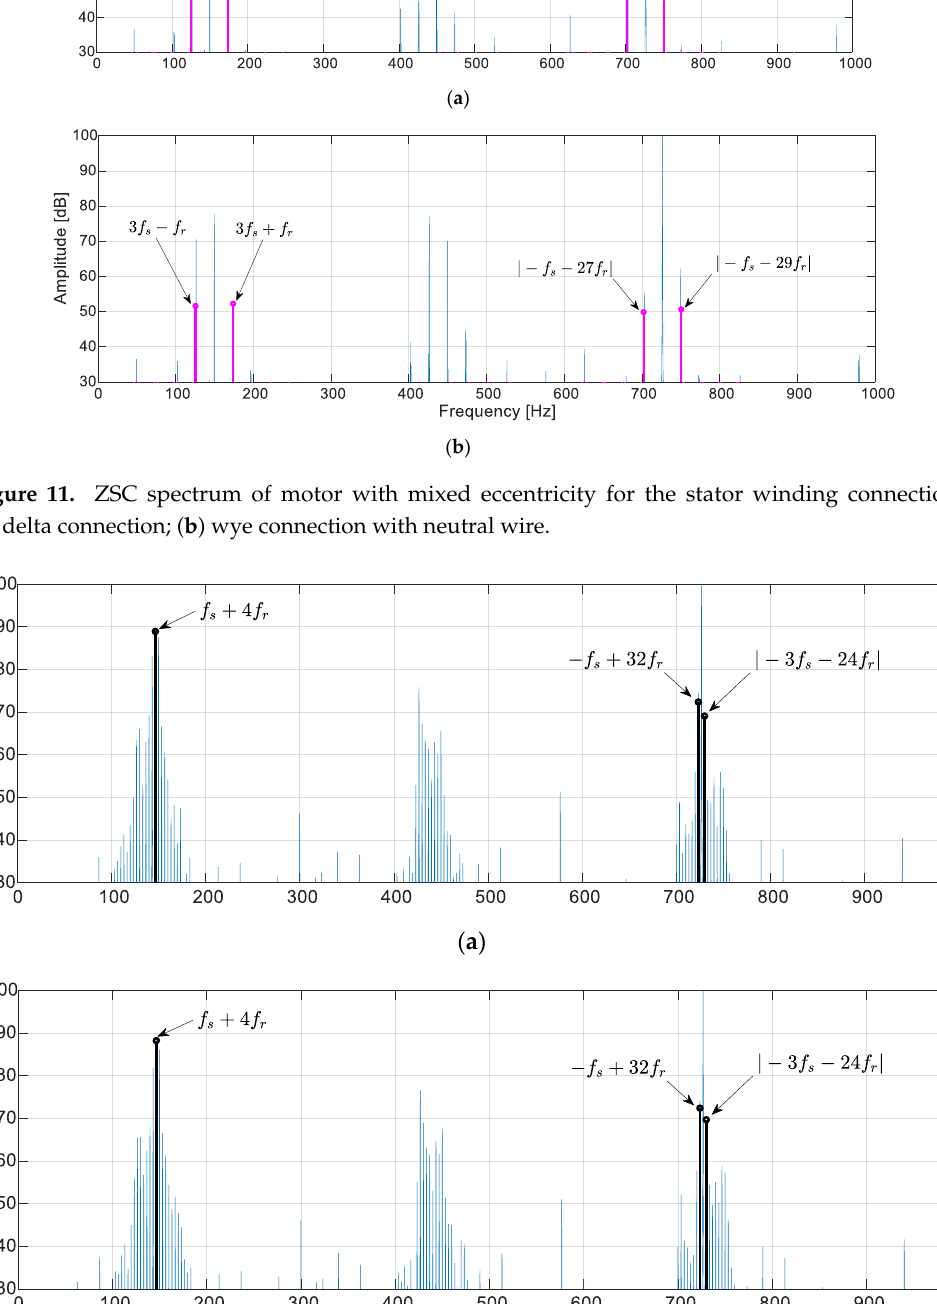
delta connection; ( b ) wye connection with neutral wire.